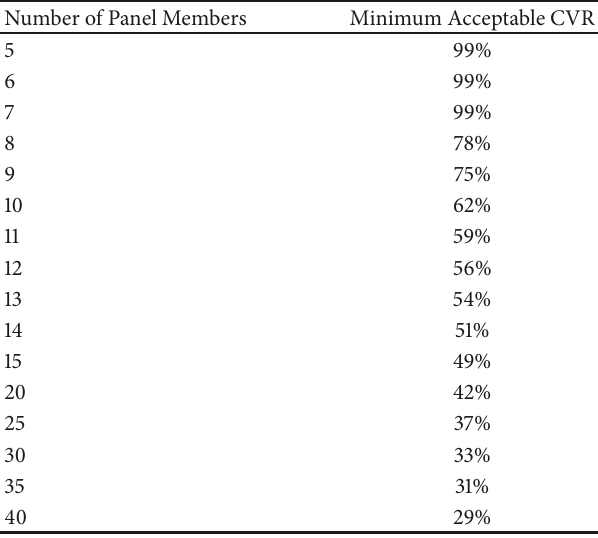
Table 2: The acceptable CVRs corresponding to the number of panel